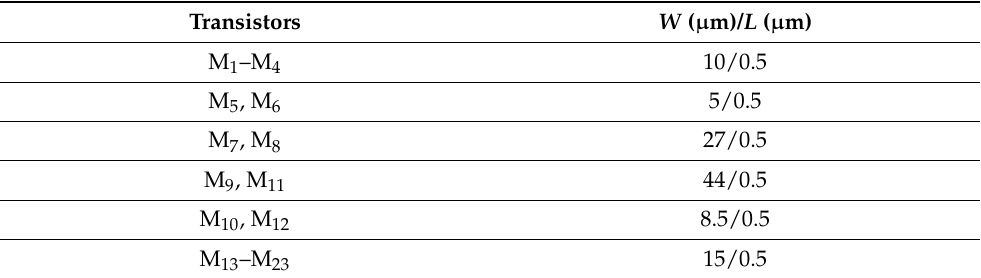
Table 1. Aspect ratio of MOS transistors used in